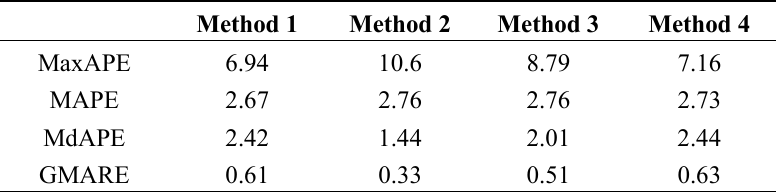
Table 2. Results of forecasting precision